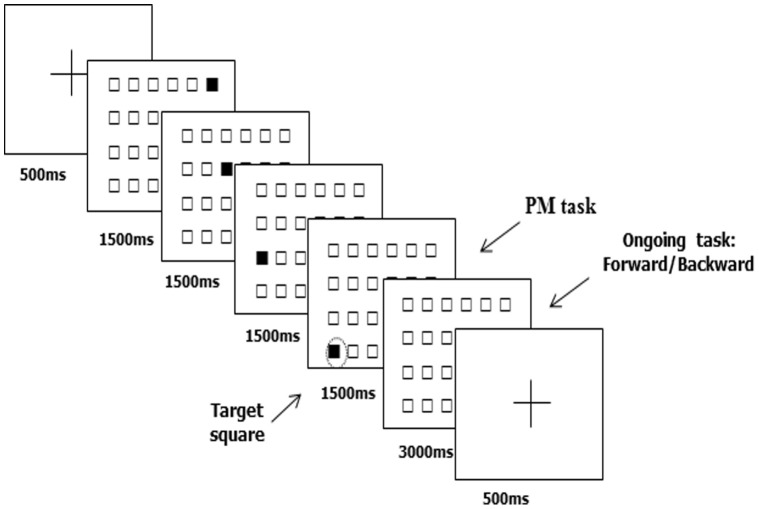
Schematic illustration of the experimental prospective memory procedure.After a study phase in which target squares were presented (here not illustrated), the subject was administered the experimental tasks in which an ongoing spatial working memory task and a PM task had to be performed. Each trial consisted of a sequence of 4 different black squares each remaining black for 1500 ms. At the occurrence of a target square subject had to press the “m” key on the keyboard (PM task). Moreover, immediately after the end of each squares sequence an empty grid appeared for 3000 ms in which subject had to reproduce the sequence in the observed or reversed order by marking the correspondent square on the screen by using the mouse (ongoing task). After a fixation cross lasting on the screen 500 ms the next trial was presented in the sequence.